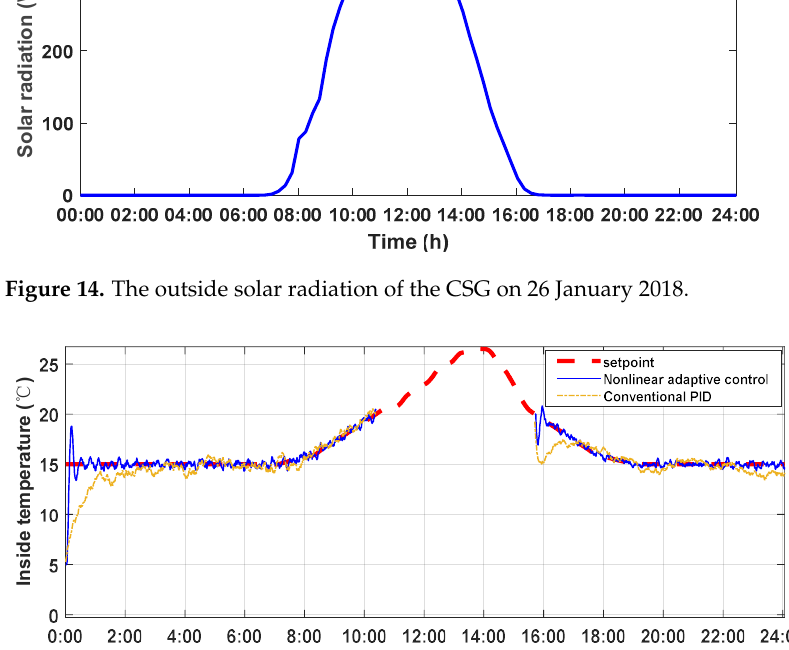
Figure 15. The corresponding response for set point of inside temperature.